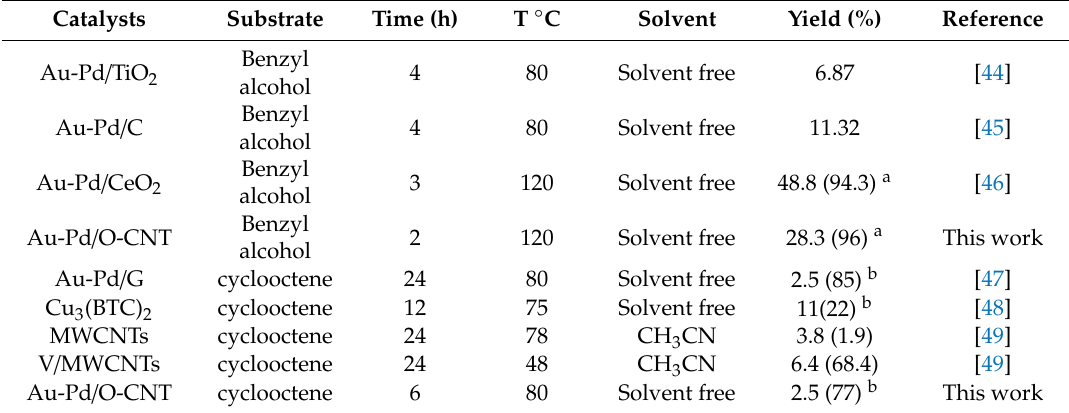
Table 3. Comparison of the oxidation of benzyl alcohol and cyclooctene performance process of di ff erent